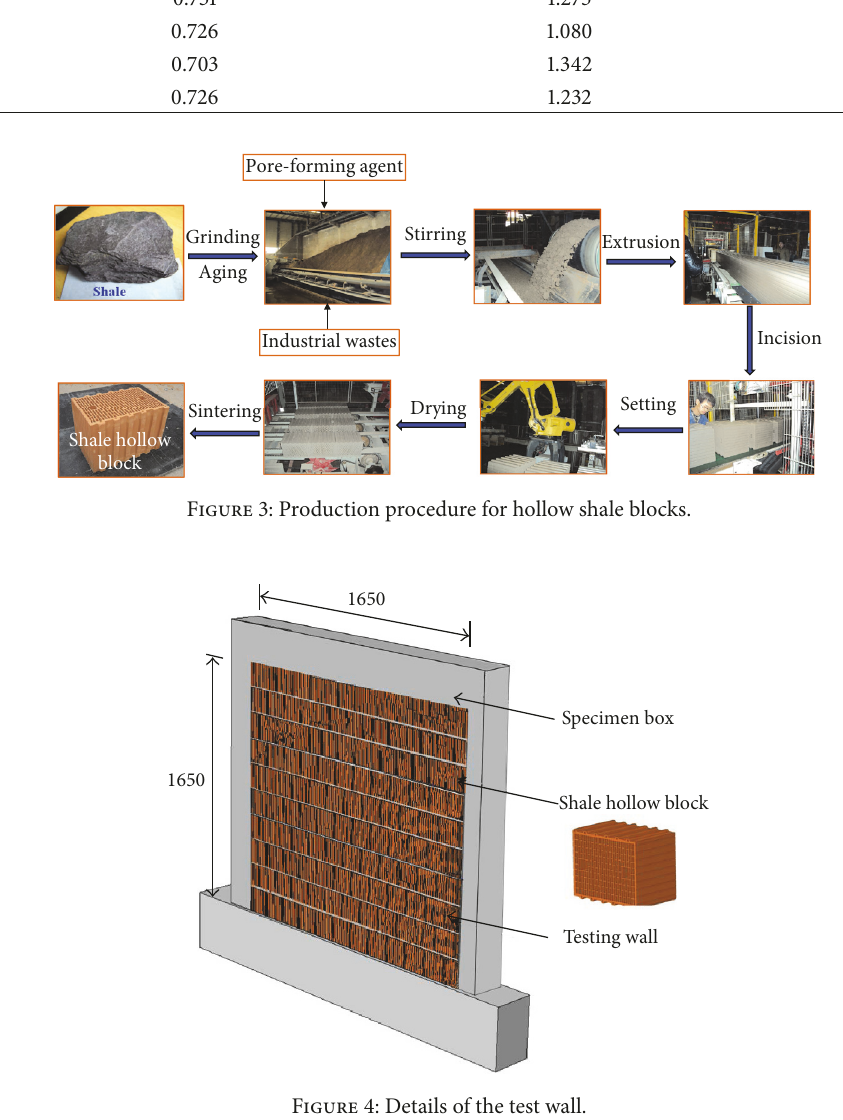
Figure 4: Details of the test